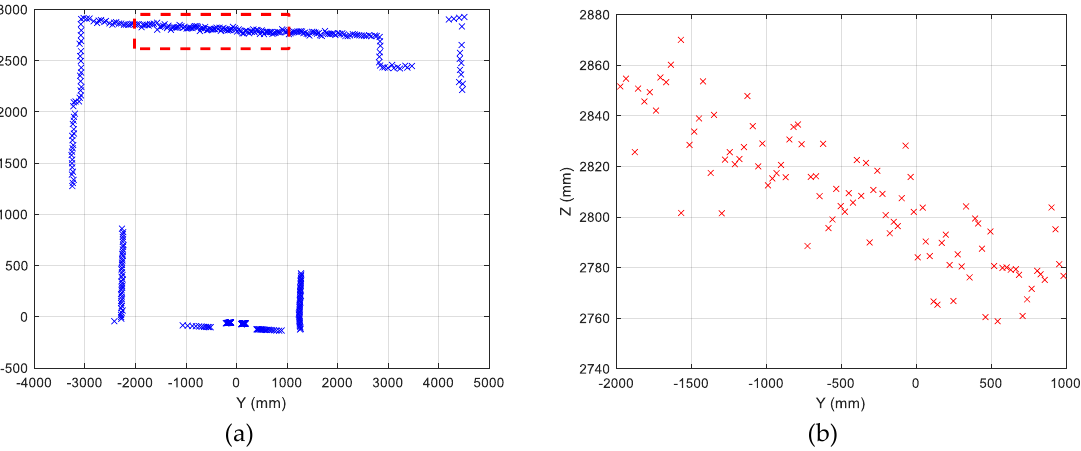
Figure 14. ( a ) Reference data used for the evaluation of the regression line in the yz-plane; ( b ) red dotted box zoom